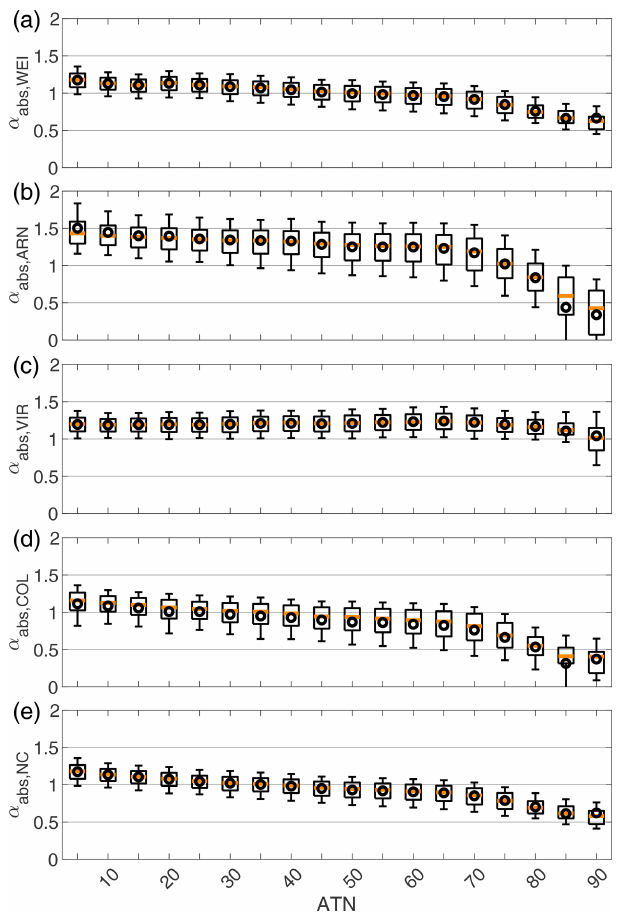
Figure 7. The dependency of the absorption Ångström exponent ( α abs ) on the AE31 filter attenuation (ATN; at 660nm) for different correction algorithms. The orange line in the middle of the box is the monthly median; the black circle is the mean; the edges of the boxes represent the 25th and 75th percentiles, and the whiskers represent the 10th and 90th percentiles of the